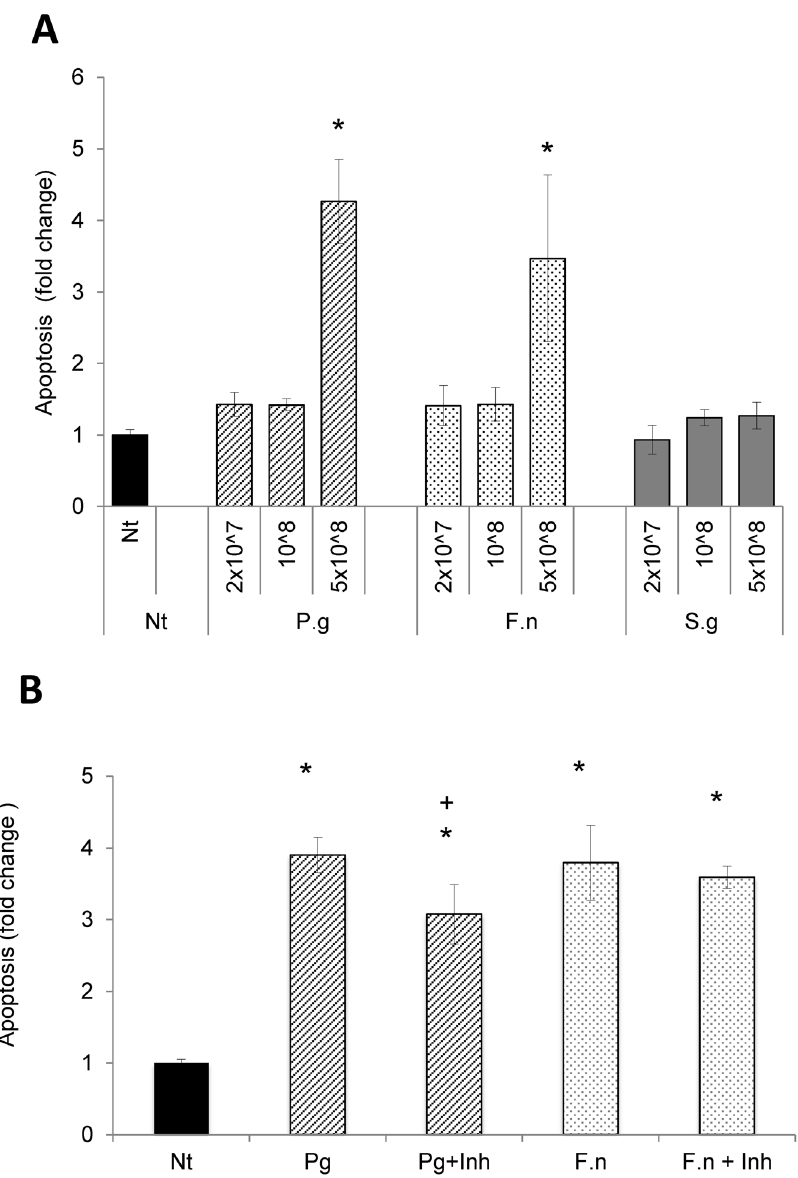
Figure 2. P. gingivalis but not F. nucleatum or S. gordonii induces apoptosis of differentiated multi-layer culture of gingival keratinocytes. P. gingivalis , F. nucleatum and S. gordonii were incubated with multi-layer, differentiated primary human gingival epithelial cells induced by air-liquid interface. Apoptosis was assessed by ELISA measuring cytoplasmic histone-associated DNA. A: Bacterial dose response. B: Incubation with the protease inhibitor leupeptin (100 m M). * Significantly different from matched control (P , 0.05). + Significantly inhibited by leupeptin (P , 0.05).